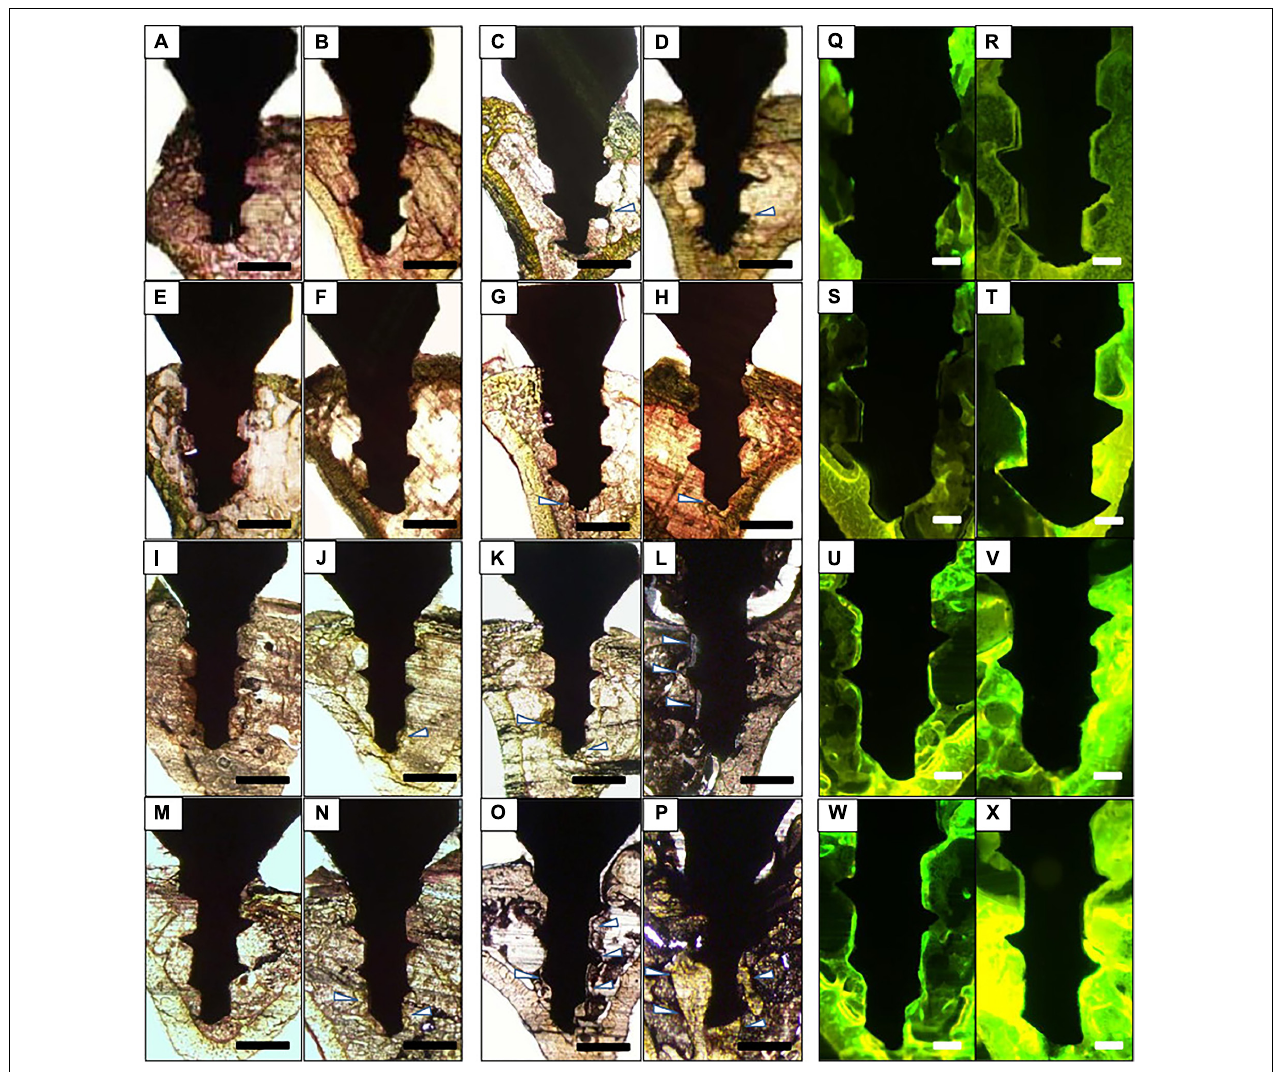
FIGURE 4 | Histology of bone formation around the implant surface. (A–P) Representative Villanueva osteochrome bone stain images of Ti (A–D) , Ti-Ca (E–H) , Ti-AE (I–L) , and Ti-AE-Ca (M–P) . (A,E,I,M) Show non-loaded implant 7 days after implantation, (B,F,J,N) show loaded implant 7 days after implantation, (C,G,K,O) show non-loaded 28 days after implantation, and (D,H,L,P) show loaded implant 28 days after implantation. Arrowheads indicate newly formed bone. (Q–X) Representative fluorescent microscopic images of implants and surrounding bone tissue. Sections of Ti (Q,R) , Ti-Ca (S,T) , Ti-AE (U,V) , and Ti-AE-Ca (W,X) with surrounding bone tissue at 28 days after implantation. (Q,S,U,W) Show non-loaded implants, and (R,T,V,X) show loaded implants (Doe et al.,